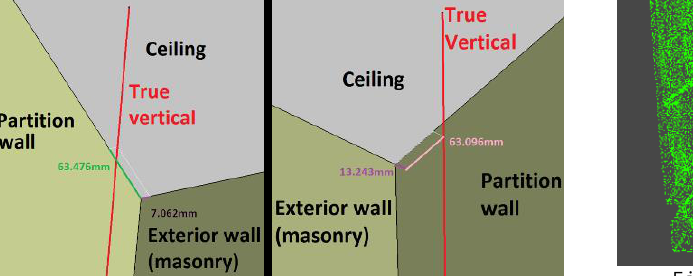
Figure 6. "as-build" model in Unity3D (point